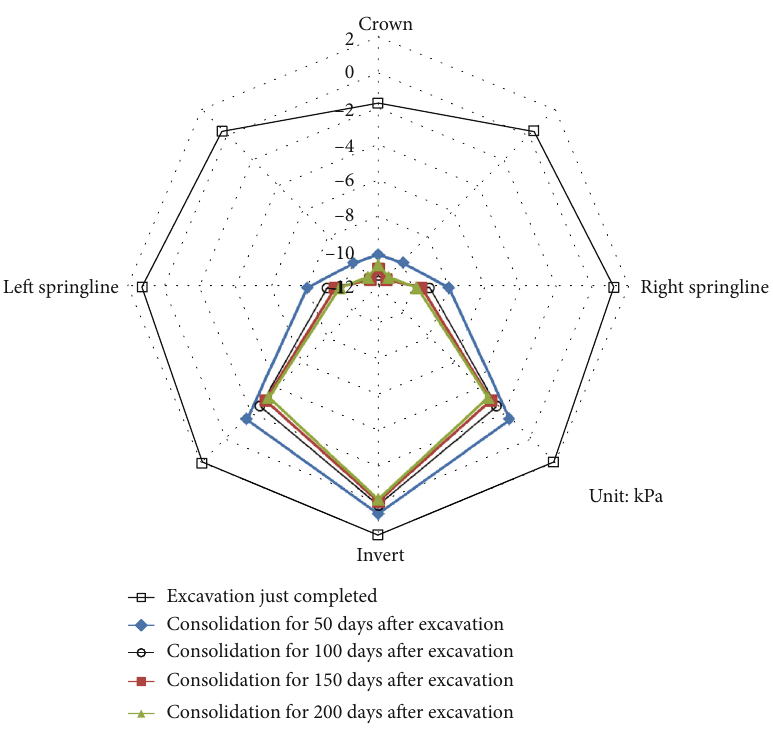
Figure 12: Soil pressure change around tunnel lining for di ff erent consolidation